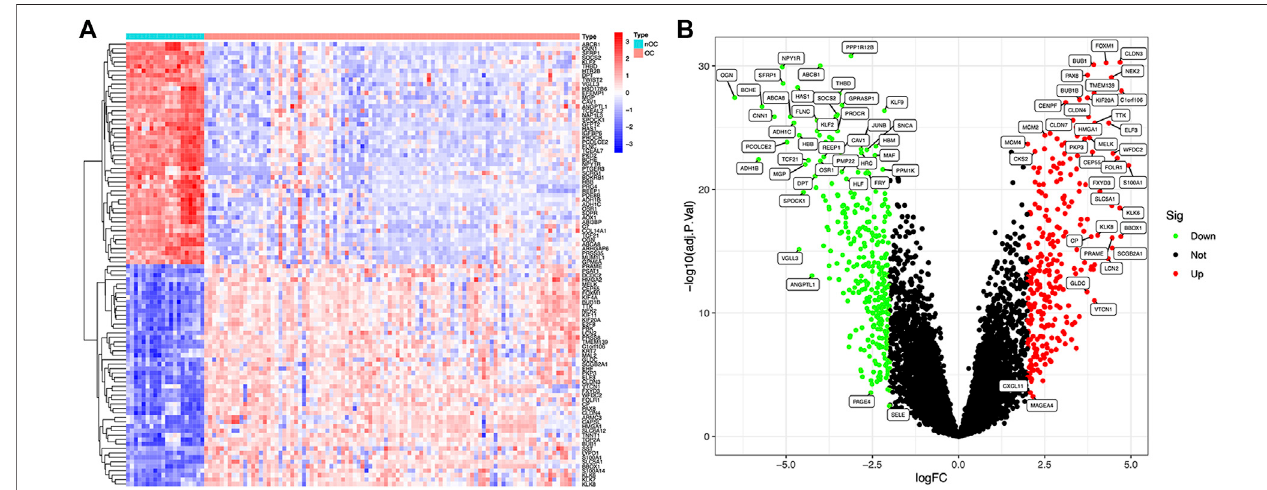
FIGURE 2 | Differentially expressed genes between OC and nOC in the training set. (A) The heat map of differentially expressed genes, highly expressed genes were red, and lowly expressed genes were blue. (B) The volcano map of differentially expressed genes. Fold changes > 2 were indicated by red (upregulation) or green